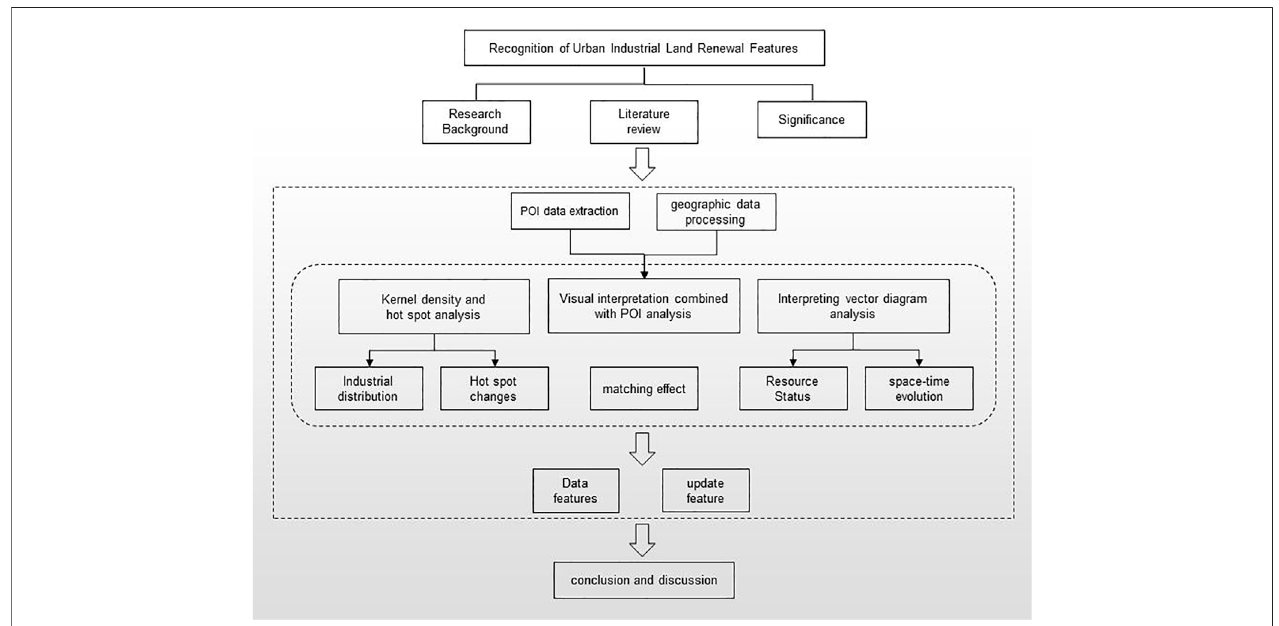
FIGURE 1 | Technology roadmap.